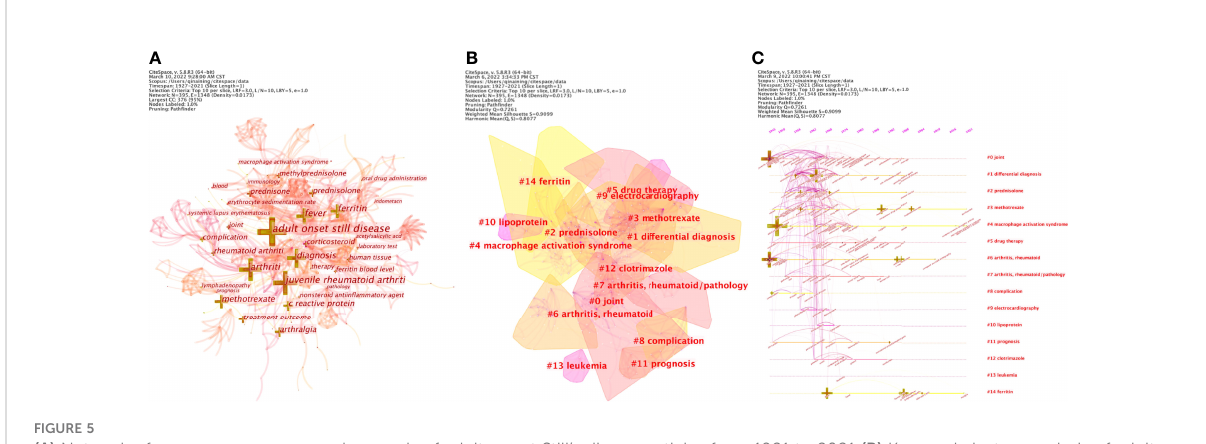
FIGURE 5 (A) Network of co-occurrence among keywords of adult-onset Still ’ s disease articles from 1921 to 2021 (B) Keyword clusters analysis of adult- onset Still ’ s disease articles from 1921 to 2021 (C) The timeline view of keyword clusters of adult-onset Still ’ s disease articles from 1921 to